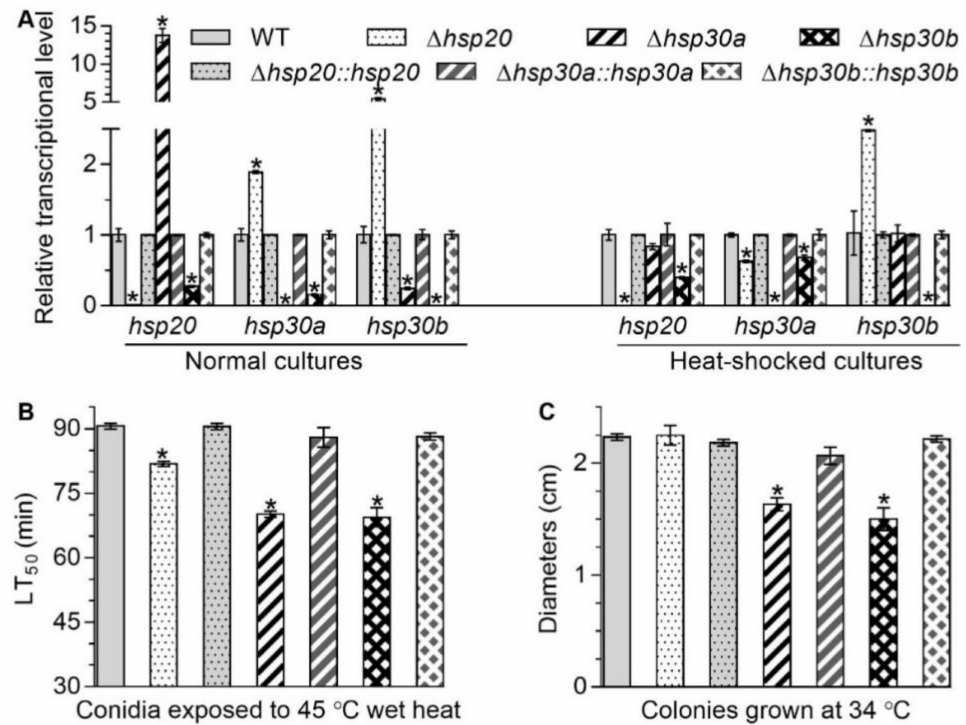
Figure 1. Changes in transcriptional profiles of hsp20 , hsp30a , and hsp30b and responses to high temperature caused by the deletion of hsp20 , hsp30a , and hsp30b in B. bassiana . ( A ) Relative transcript levels of hsp20 , hsp30a , and hsp30b in the 3-day-old SDAY cultures of each mutant exposed or not exposed to 40 ◦ C for 1 h. ( B ) LT 50 for conidial tolerance to 45 ◦ C wet heat. ( C ) Diameters of fungal colonies after 8 days of cultivation in SDAY at 34 ◦ C. Asterisked bars in each bar group differ significantly from those unmarked (Tukey’s HSD, p < 0.05). Error bars: SD from three